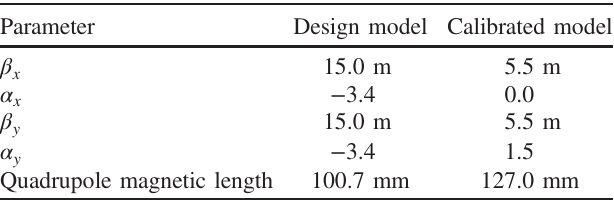
TABLE I. Parameter values in the design and calibrated CLARA machine models. Optics functions are given at the tomography reconstruction point (the exit of the linac).